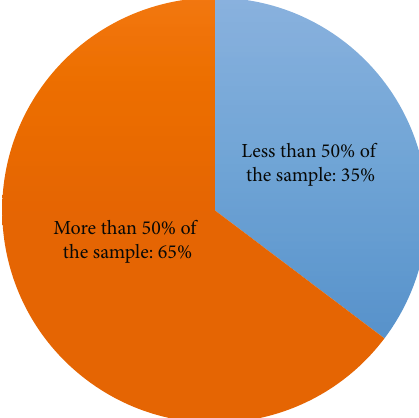
Figure 3: GG (Val/Val) genotype frequency distribution of the BDNF (rs6265) genetic variant in MDD sample population